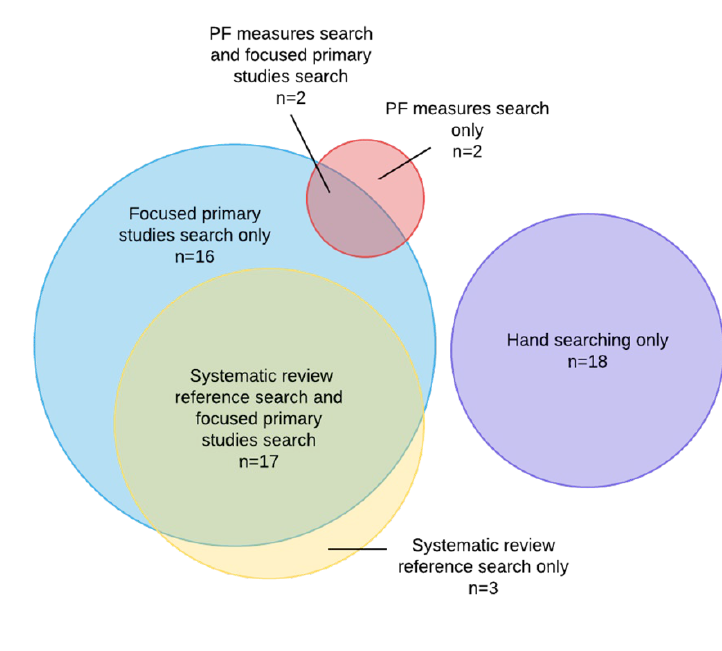
Figure 2 Visualization of overlap in recall of each search component used in Hayden et al.’s review [28]*